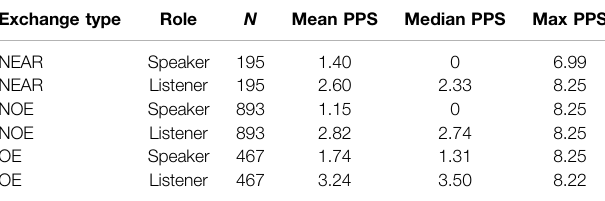
TABLE 6 | Turn Receipt Head PPS summary statistics (pooled over